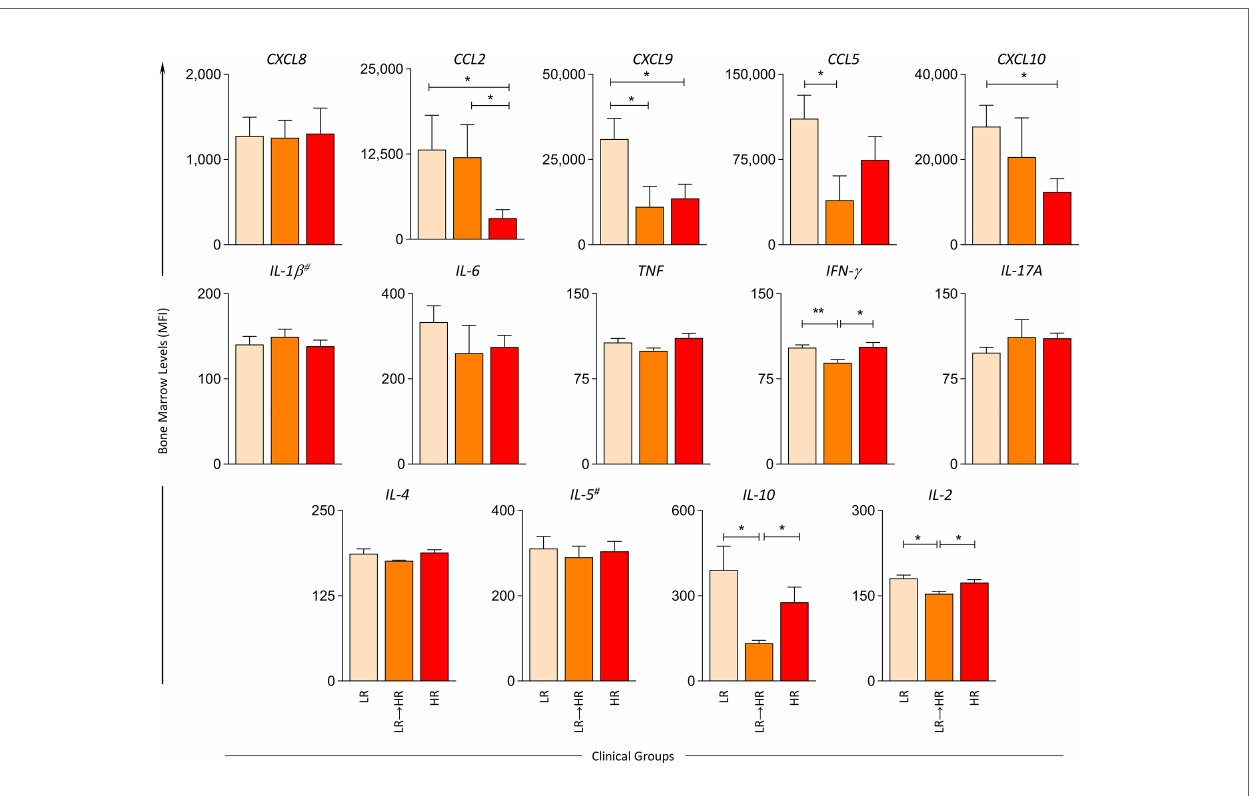
FIGURE 1 | Bone marrow soluble mediators in B-ALL patients according to the risk group strati fi cation on D15. The levels of bone marrow soluble mediators (CXCL8, CCL2, CXCL9, CCL5, CXCL10, IL-1 b # , IL-6, TNF, IFN- g , IL-17A, IL-4, IL-5 # IL-10, IL-2) were measured at the baseline (D0) in B-ALL patients categorized according to their risk group strati fi cation on D15 of induction therapy, denominated as LR ( ), LR ! HR ( ) and HR ( ) subgroups. Soluble mediators were quanti fi ed by cytometric bead array (CBA) and ELISA (IL-1 b and IL-5) # assays as described in the Materials and Methods section. Data are reported as mean concentration ± standard error expressed in mean fl uorescence intensity (MFI) or pg/mL (IL-1 b and IL-5). Statistical analyses were performed using Student ’ s t test or the Mann Whitney test and signi fi cant differences are underscored by connecting lines and asterisks for p < 0.01 (**) or p < 0.05